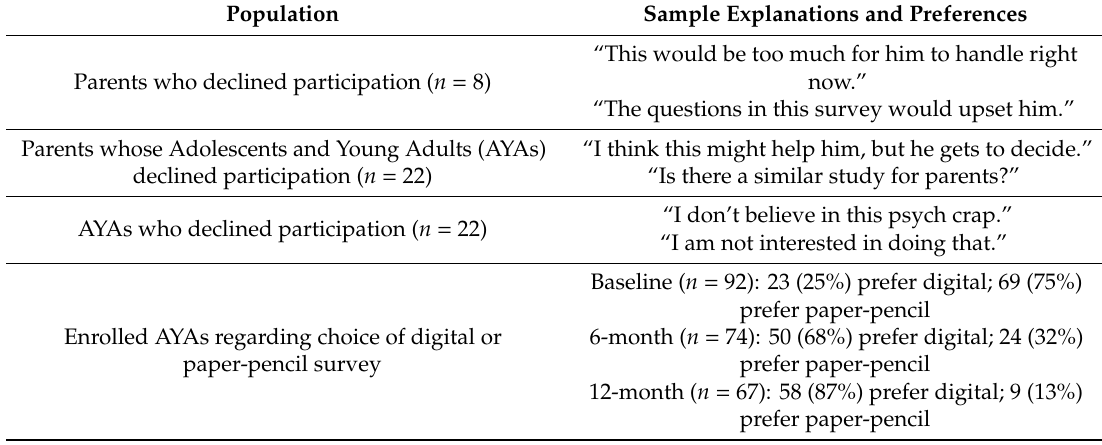
Table 2. Characteristics of participants who ( A ) enrolled and completed surveys, ( B ) enrolled and did not complete surveys, and ( C ) who declined enrollment.